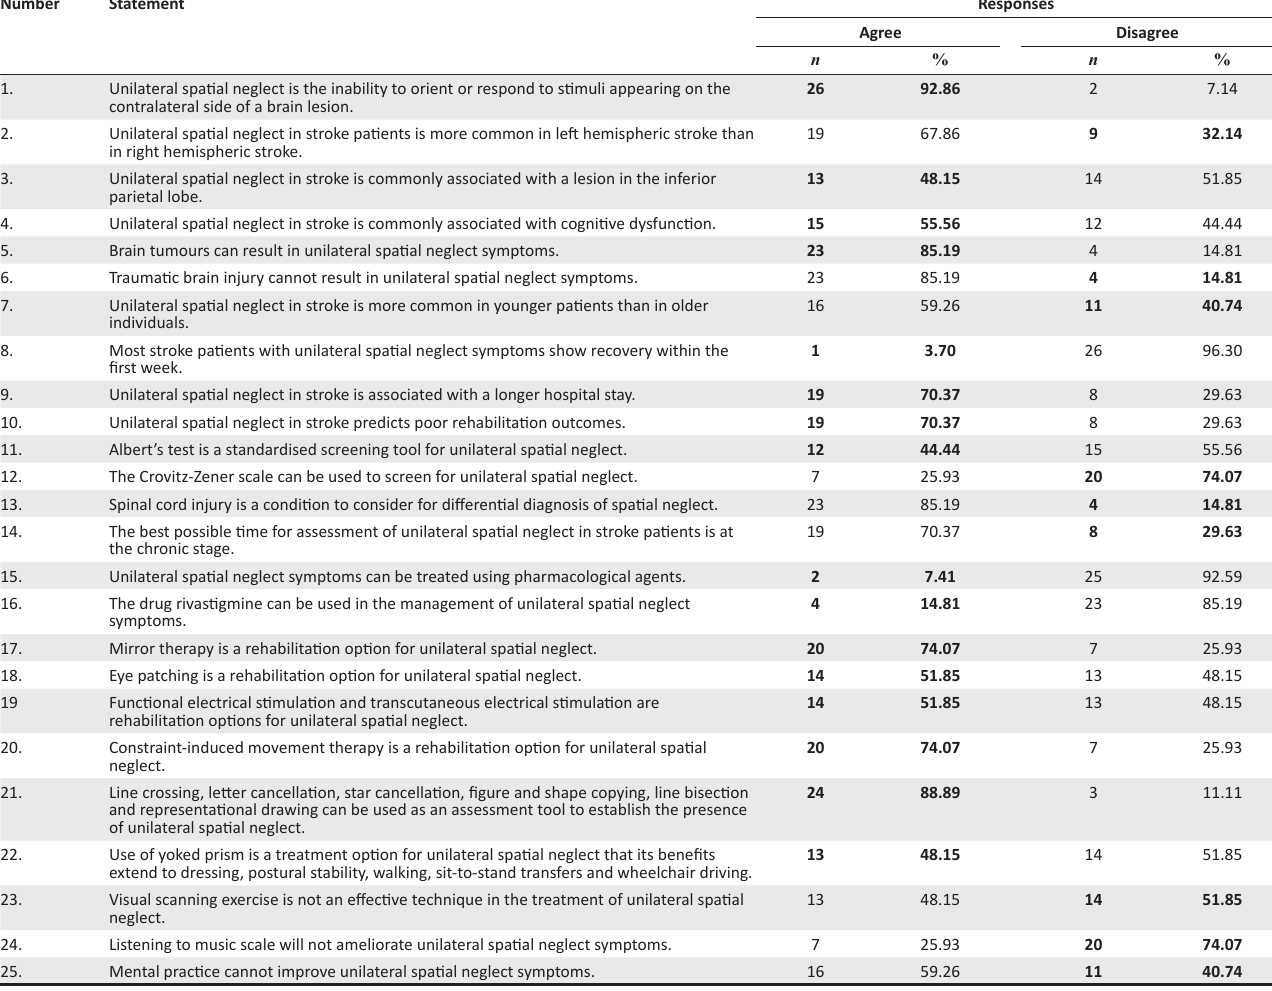
TABLE 4: Item-by-item frequency distribution of responses of physiotherapists to questions on knowledge on unilateral spatial neglect. Number Statement Responses